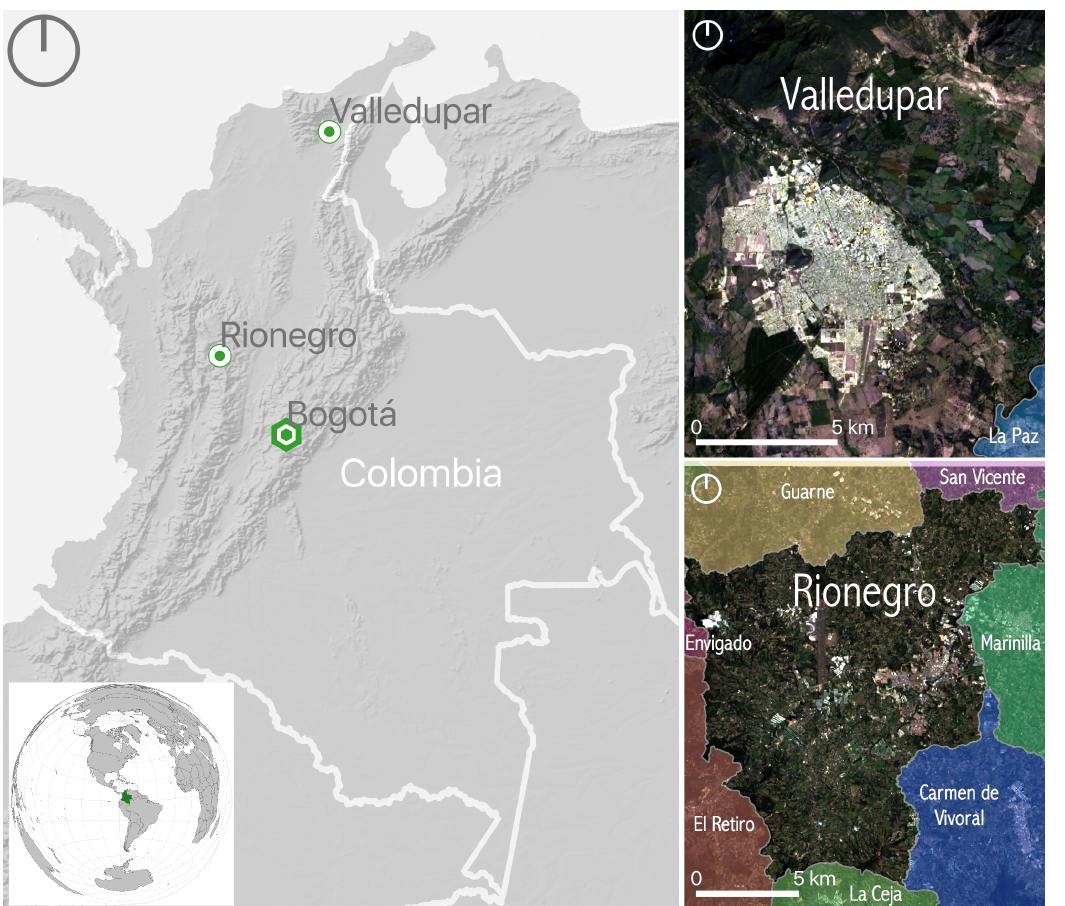
Figure 14. Left: location of Valledupar and Rionegro in Colombia. Right: administrative divisions within the selected geographic extents for Valledupar and